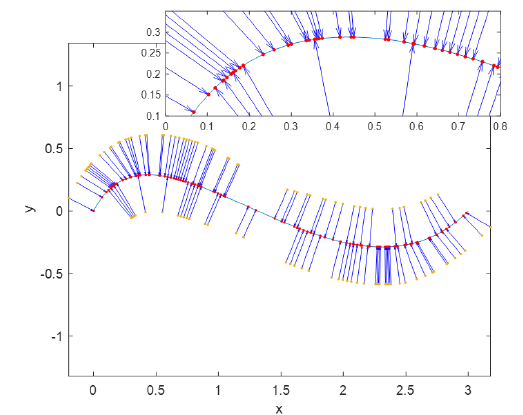
Figure 10. Recursive first-order algebraic point projection at test distance ¯ d = 0.3.